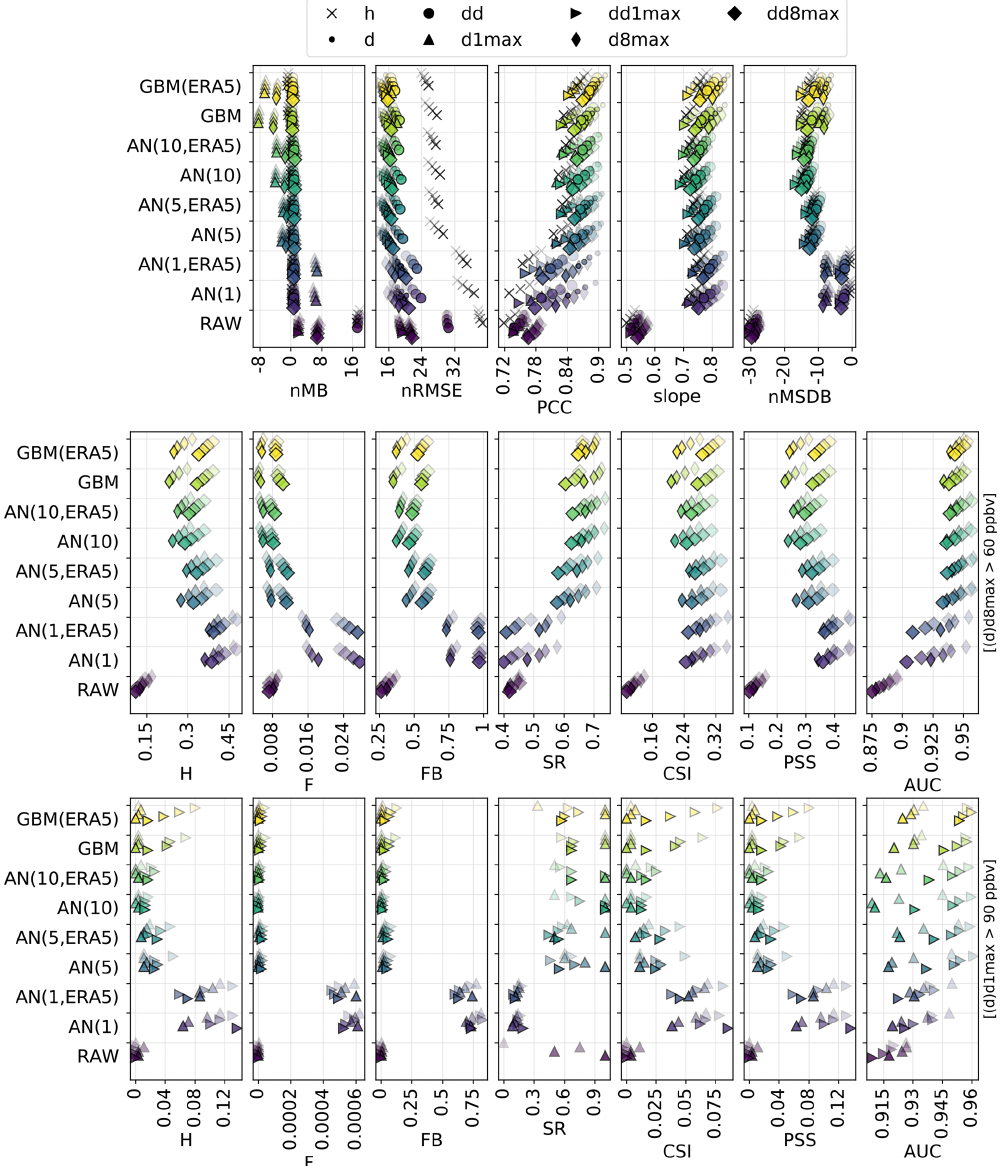
Figure G6. Similar to Fig. 3 for sensitivity tests on the meteorological data (HRES versus ERA5) used in the AN and GBM methods.